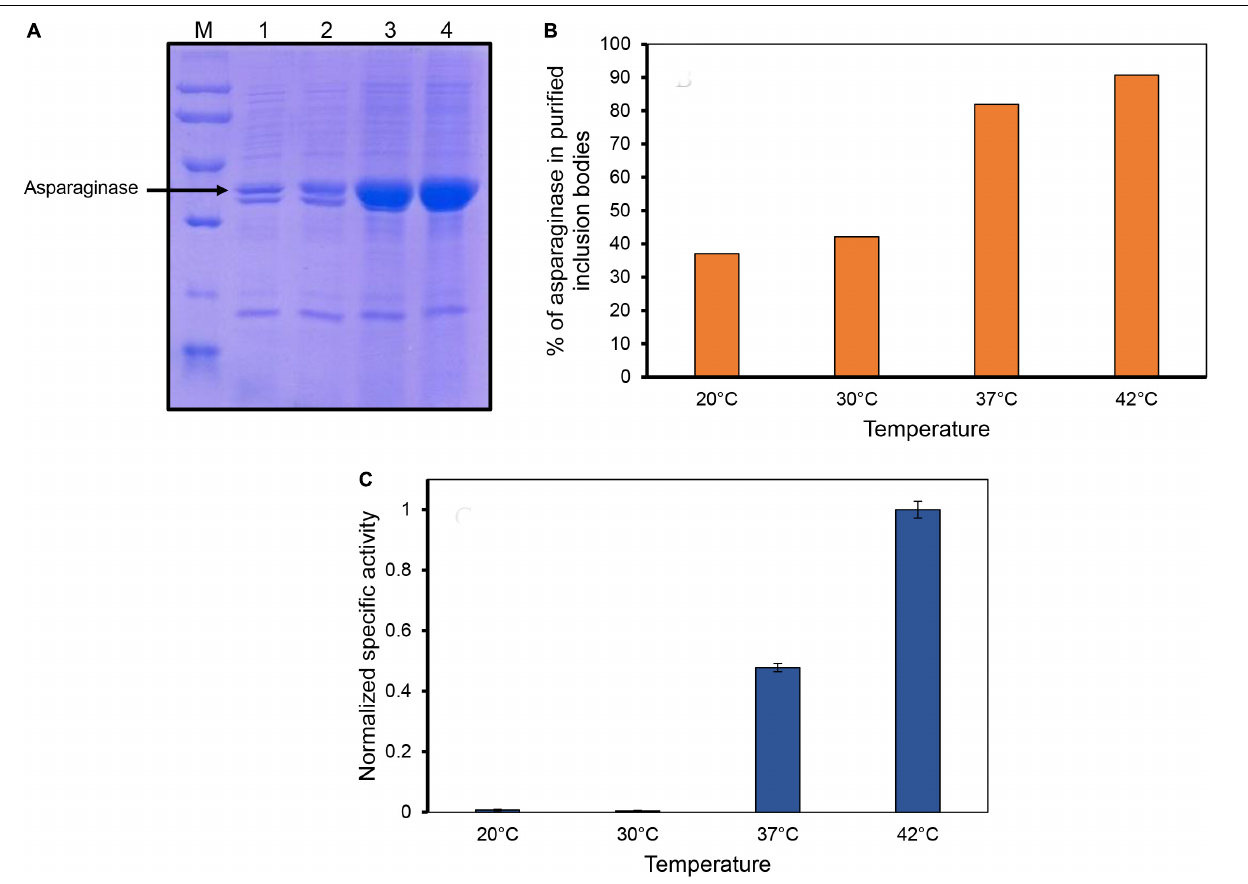
FIGURE 2 | Inclusion body purification and determination of asparaginase activity in purified inclusion bodies. (A) SDS-PAGE analysis of purified inclusion bodies expressed at different temperatures. Lane M, low molecular weight marker (97, 66, 45, 30, and 20.1 kDa); Lane 2, lane 3, lane 4, and lane 5 are asparaginase inclusion bodies expressed at 20, 30, 37, and 42 ◦ C, respectively. (B) Percentage of asparaginase in purified asparaginase inclusion bodies. (C) Normalized specific activities of asparaginase inclusion bodies expressed at different temperatures. Error bars represent standard deviations from two independent experiments ( N = 2).